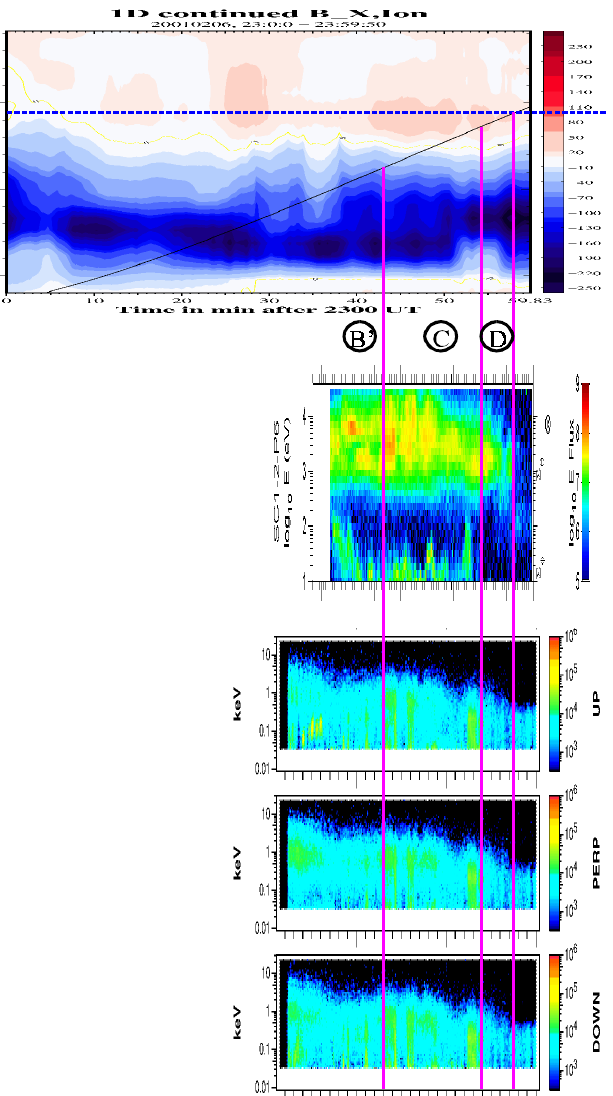
Fig. 10. PEACE electron spectra for downgoing (lowest panel), perpendicular to the magnetic field (second panel from the bottom), and upgoing (third panel from the bottom) electrons, from Cluster spacecraft 1; CIS ion spectrum from Cluster spacecraft 1, integrated over all elevations and azimuths (second panel from the top); for orientation, the magnetic field on the ionospheric level (upper panel, as in Fig. 3, left panel) is also plotted, together with the magnetic footprint path of spacecraft